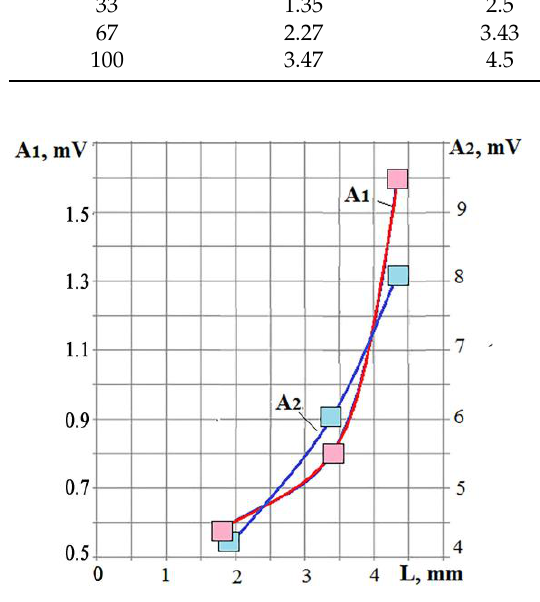
Figure 25. The relationship of the parameters of the VA signals with the die-sinking performance L, where A 1 is of 1.5 – 3 kHz; A 2 is of 5 – 11 kHz. Table 1. Parameters of VA signals for EDM of low-carbon steel.